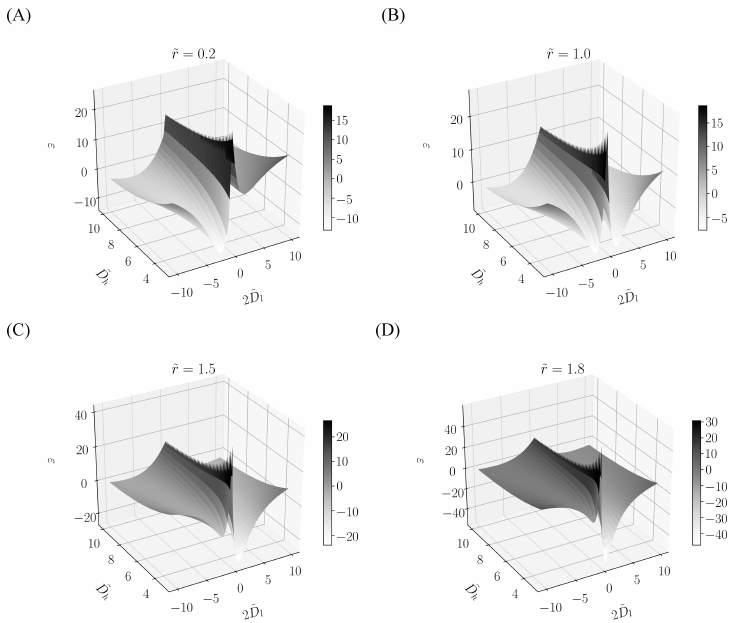
Figure 13. Relative error (percentage) when ˜ r , ˜ D l , ˜ D h took different